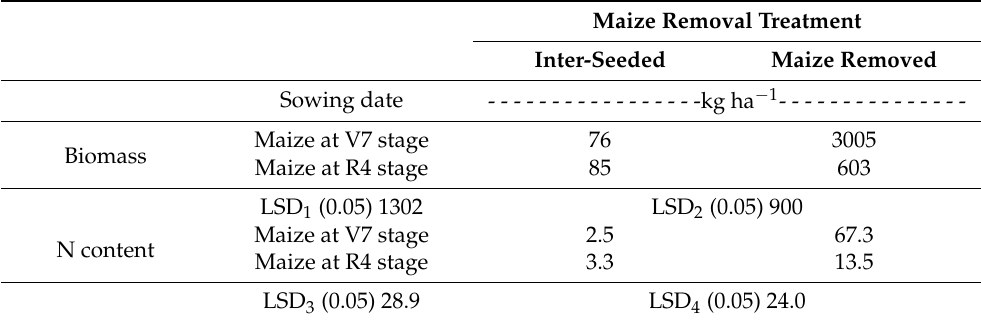
Table 4. Effect of sowing date and maize removal at the time of sowing on cover crop biomass and total nitrogen content in this biomass averaged over locations and cover crop